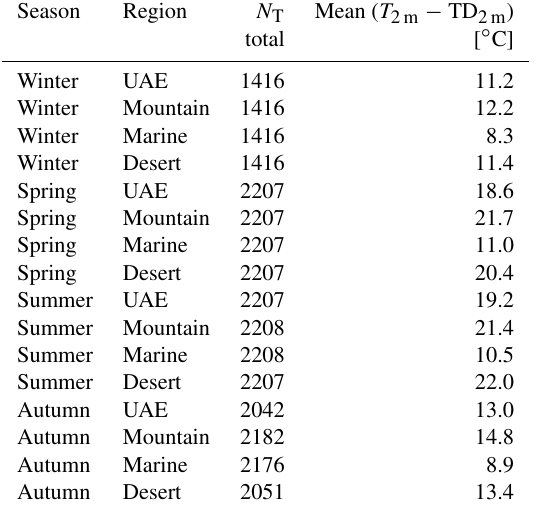
Table 5. Seasonal and regional differences in observed T 2m and TD 2m means to show the closeness to saturation. Included are the number of time steps for each season ( N T ). Note that this is not a mean of the differences between T 2m and TD 2m calculated at each time step, but an overall difference in